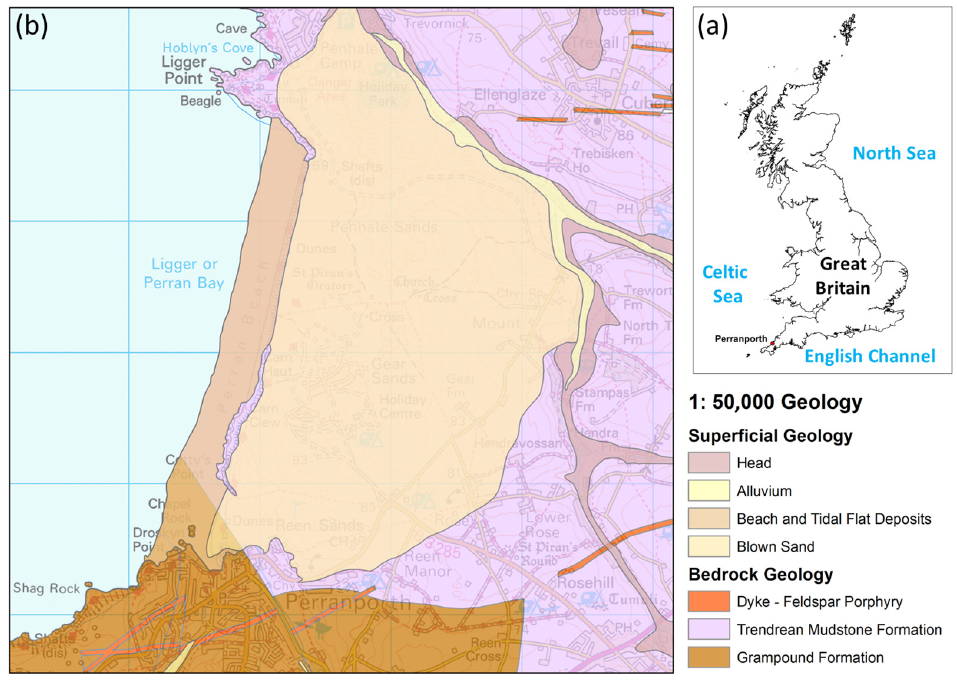
Figure 2. Study site location: ( a ) Great Britain High Water Mark; ( b ) Perranporth Beach showing the superficial and bedrock geology of the study area. Map shown in metric scale using British National Grid (blue grid). For reference, the latitude and longitude of Ligger Point is 50°22 ′ 48.0 ″ N, 5°09 ′ 21.7 ″ W.